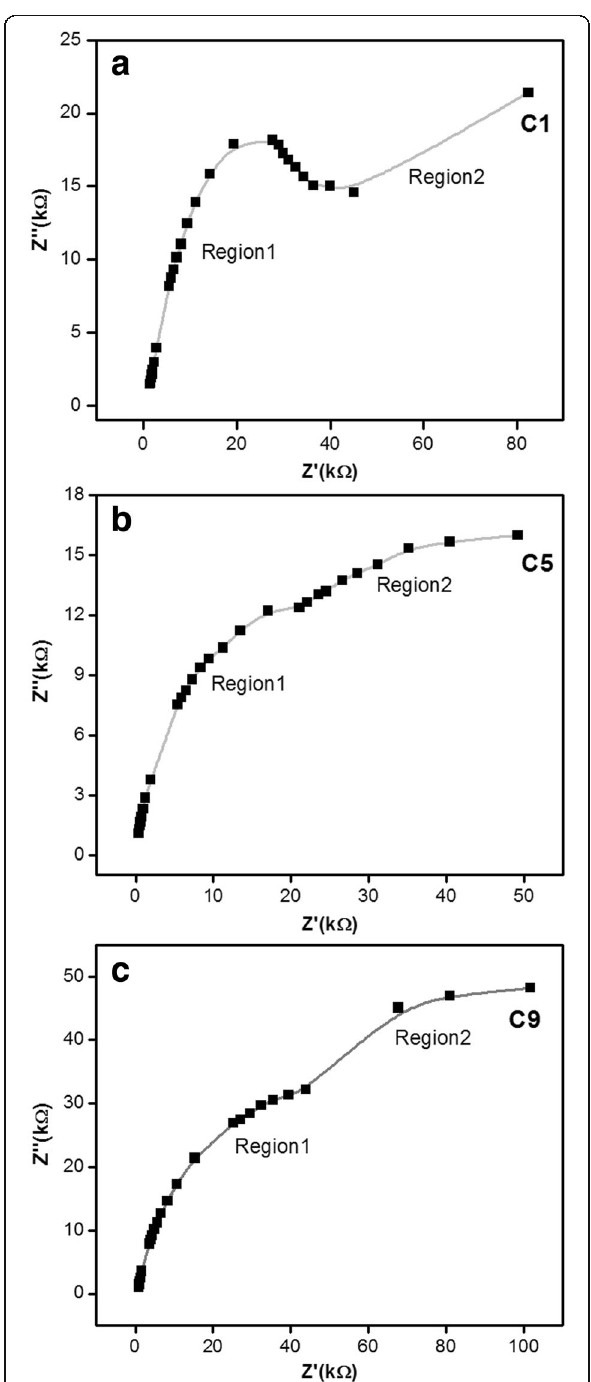
Fig. 7 a – c Nyquist ’ s plot ( Z ′ vs Z ″ ) for C1( x = 0.1, y = 0.45), C5( x = 0.5, y = 0.25), and C9( x = 0.9, y =